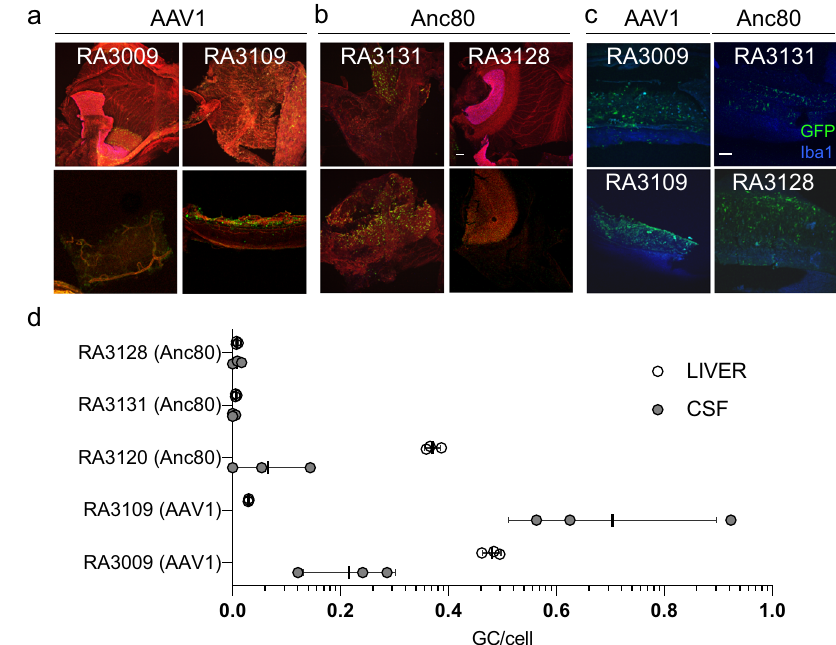
Fig. 5 In vivo transduction of vestibular epithelia and other organs with AAV1 and Anc80L65 in rhesus macaques. Representative whole mounts of the sensory epithelium from utricle, saccule, ampulla, and membranous semicircular ducts from animals that received a AAV1 ( n = 2) or b Anc80L65 ( n = 2). eGFP signal (green) was detected in three of the four animals that expressed eGFP; no expression was detected in animals RA3128 and RA3120. Red, phalloidin. Scale bar, 100 µ m. c eGFP (green) expression was detected in the lateral wall along the length of the cochlea ( n = 2 animals for Anc80L65 and n = 2 animals for AAV1); no differences were noticed between serotypes. Resident macrophages were stained with anti-Iba1 antibody. Scale bar, 100 µ